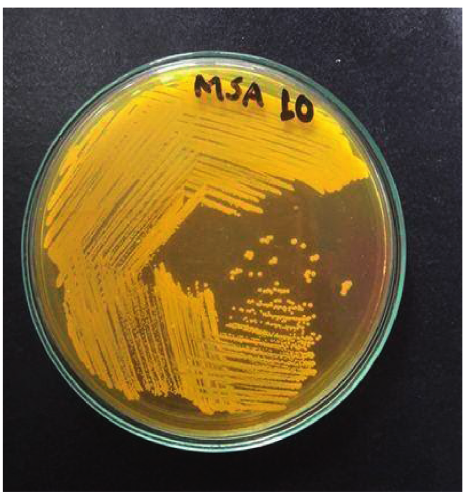
Figure 1: Growth of S. aureus on mannitol salt agar (yellow colonies after 24 hours incubation at 37 ° C) (isolate no.